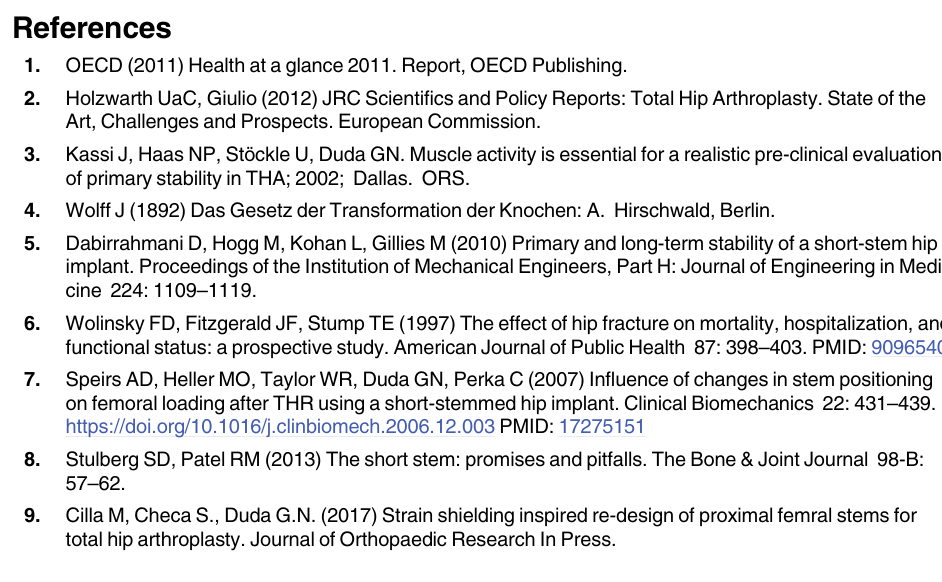
S1 Fig. Geometry of original and optimized